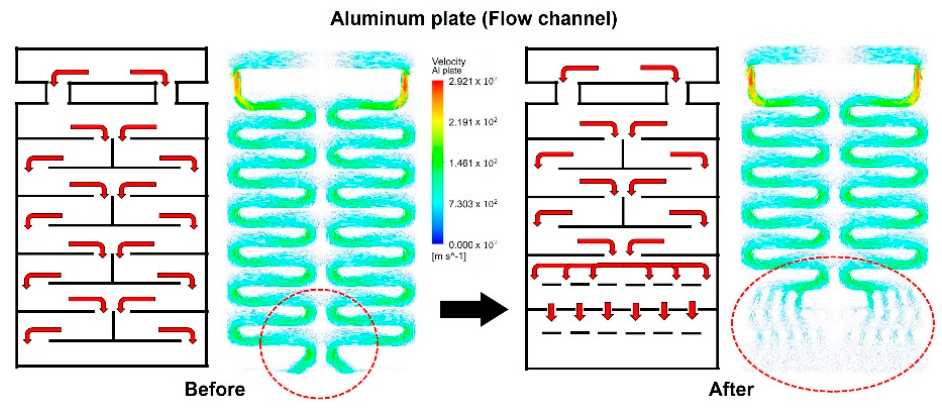
Figure 9. Improvements in the flow channel to achieve a uniform temperature distribution.